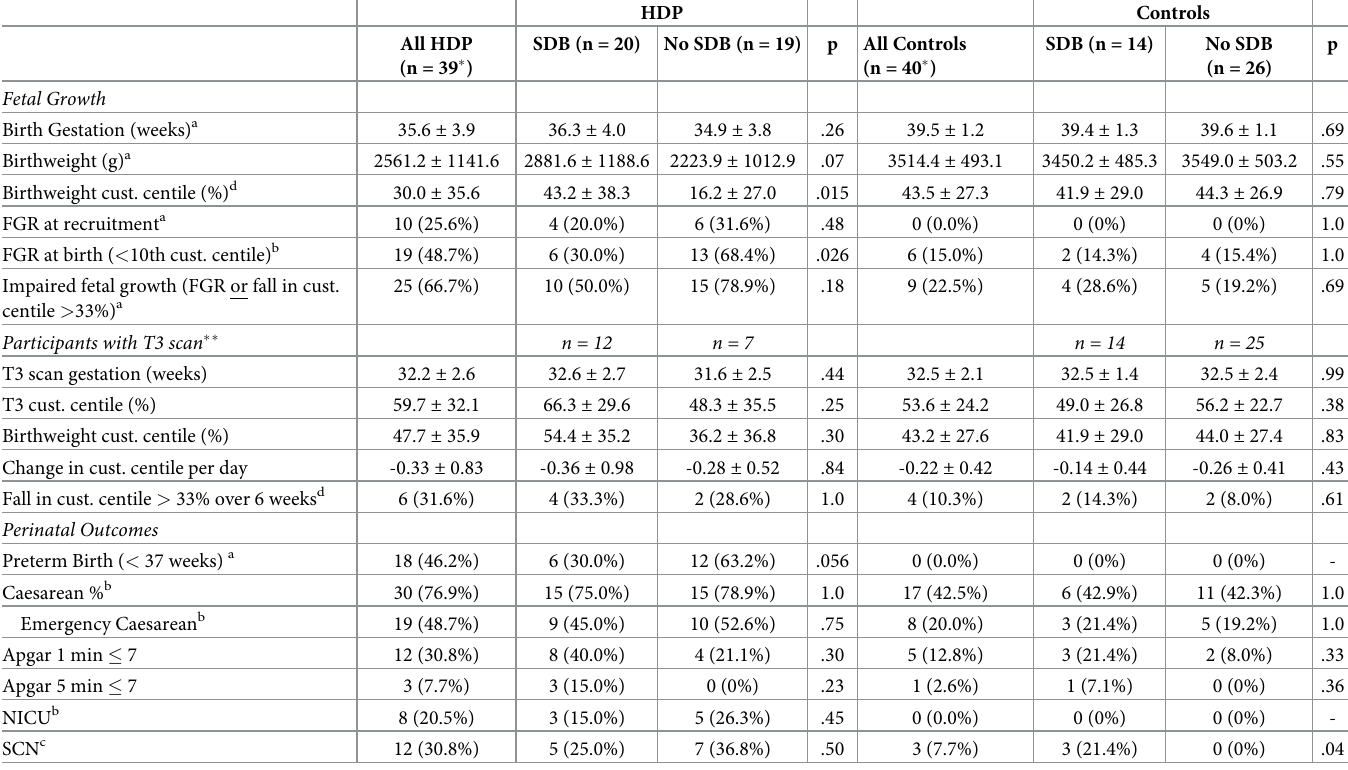
Table 4. Measures of fetal growth and perinatal outcomes for those with and without SDB in the hypertensive disorders of pregnancy and control groups.